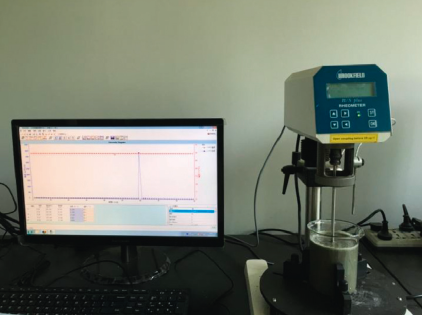
Figure 4: Rheometer